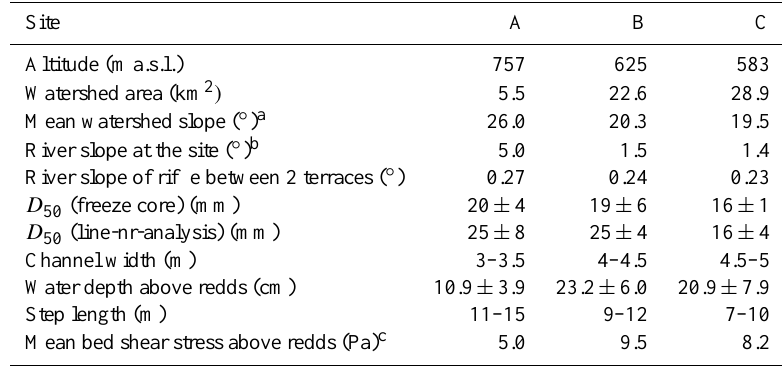
Table 1. Site characteristics: D 50 of the riverbed sediment was defined by freeze core samples and with line-number-analyses (Fehr, 1987). Data are given as mean ± standard